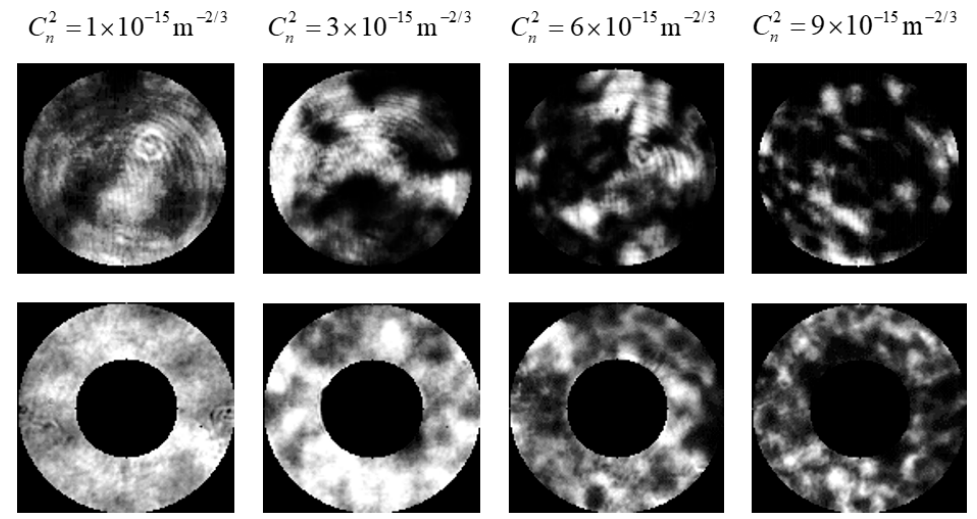
Figure 3. Example of scintillation patterns acquired from the TurbNet-LB sensor ( top row ) and TurbNet-LED sensor ( bottom row ) for weak-to-strong turbulence conditions, as characterized by C 2 n values measured by the BLS 2000 scintillometer. Scintillation images obtained with the TurbNet-LED sensor have a characteristic black circular area due to laser-light obscuration by the Schmidt–Cassegrain telescope secondary mirror.